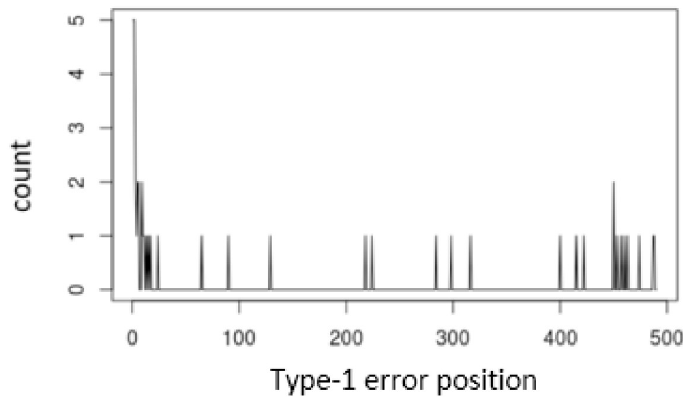
Fig 4. Type-1 error frequency of the AR(1) model based on Eq